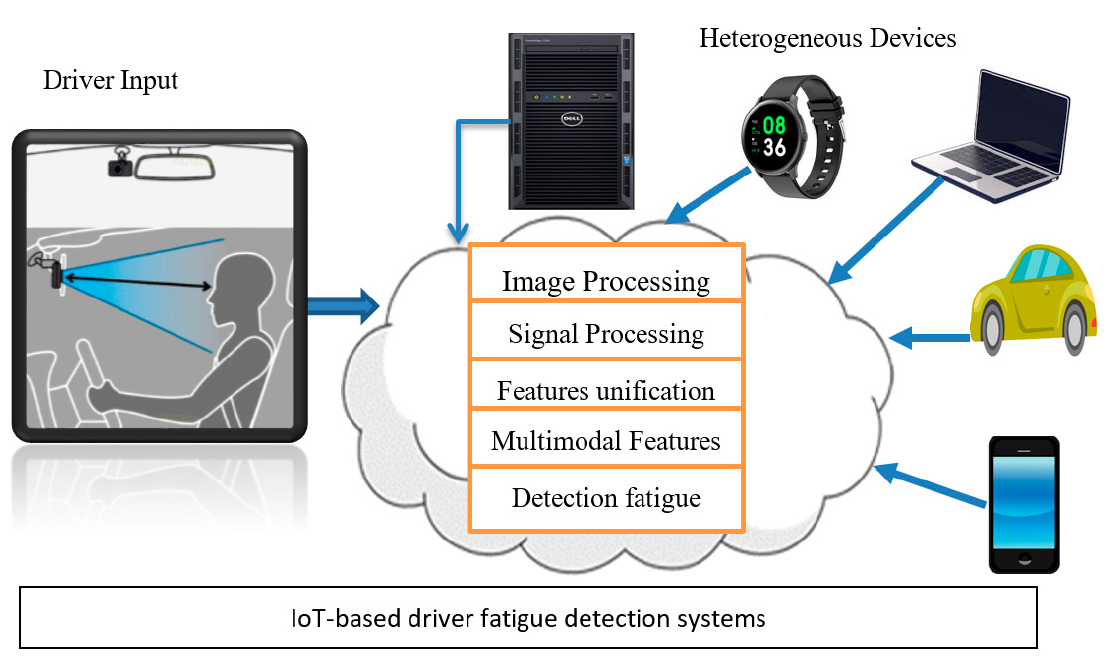
Figure 2. A visual example of cloud-based driver fatigue detection (DFD) systems developed in the past by using internet of things (IoT)-based architecture.